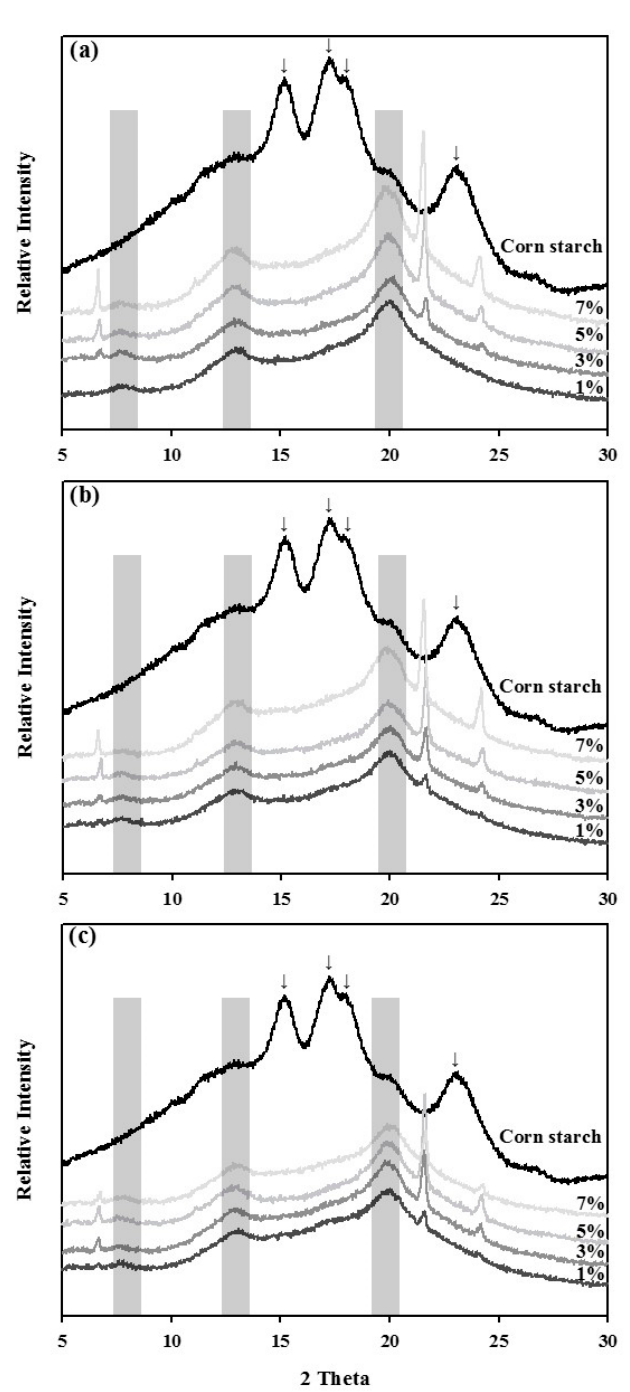
Figure 1. X -ray di ff raction spectra of corn starch-stearic acid complexes prepared at di ff erent Figure 1. X -ray diffraction spectra of corn starch-stearic acid complexes prepared at different temperatures and with di ff erent stearic acid / corn starch ratios. ( a ) 75 ◦ C, ( b ) 65 ◦ C, ( c ) 55 ◦ temperatures and with different stearic acid/corn starch ratios. ( a ) 75 °C, ( b ) 65 °C, ( c ) 55 °C.